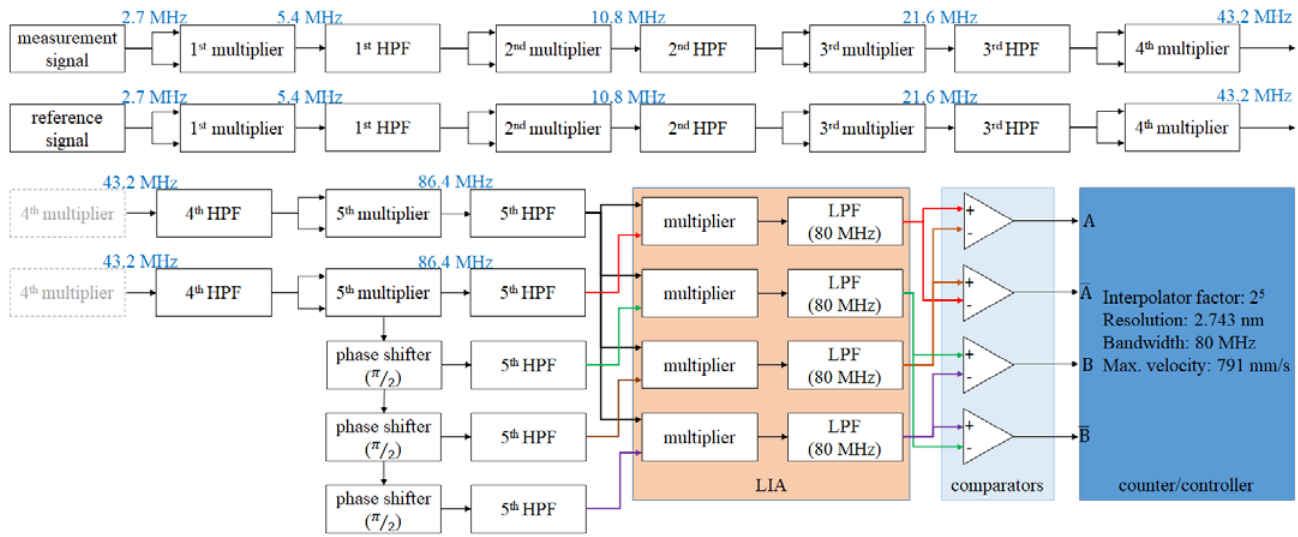
Figure 7. Example: block diagram of 5 th − order analog interpolator.